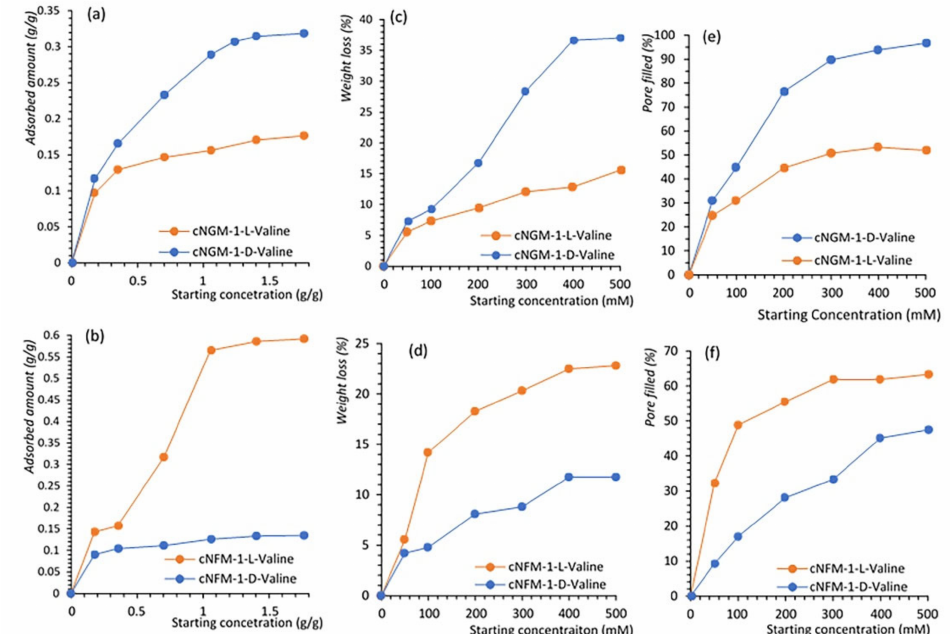
Figure 2. Equilibrium adsorption profiles for valine enantiomer on c NGM-1 and c NFM-1 mesoporous materials, as measured by: monitoring changes to the circular dichroism spectroscopy (CD) spectra of the valine solution after removal of the adsorbent via filtration ( a , b ); adsorbent percentage weight loss after filtration as measured by thermogravimetric analysis ( c , d ); and as a function of the